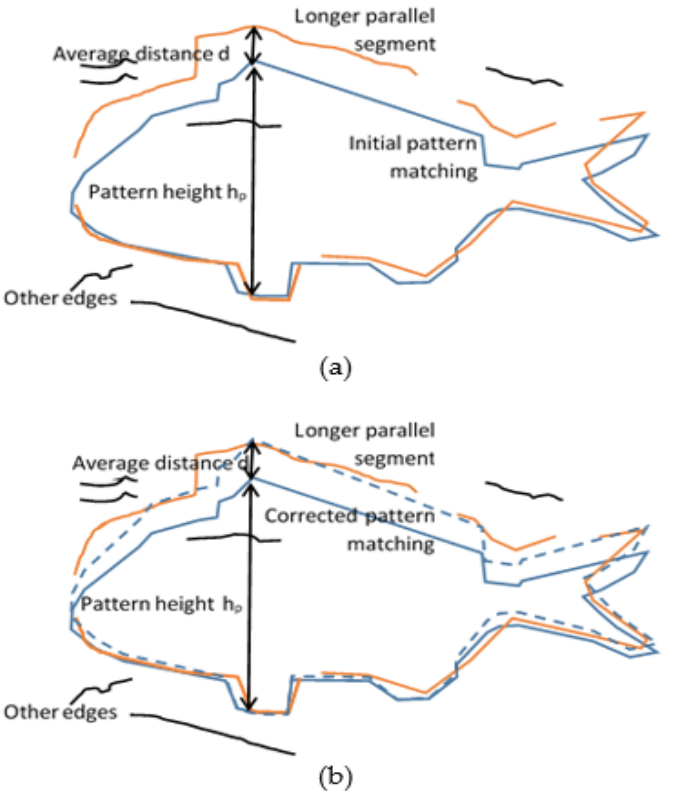
Figure 9. An initial contour pattern matching that is based mainly on the lower part of the contour ( a ) and the corrected contour pattern that has been stretched vertically to fit to the unmatched longer parallel segment on the top ( b ).